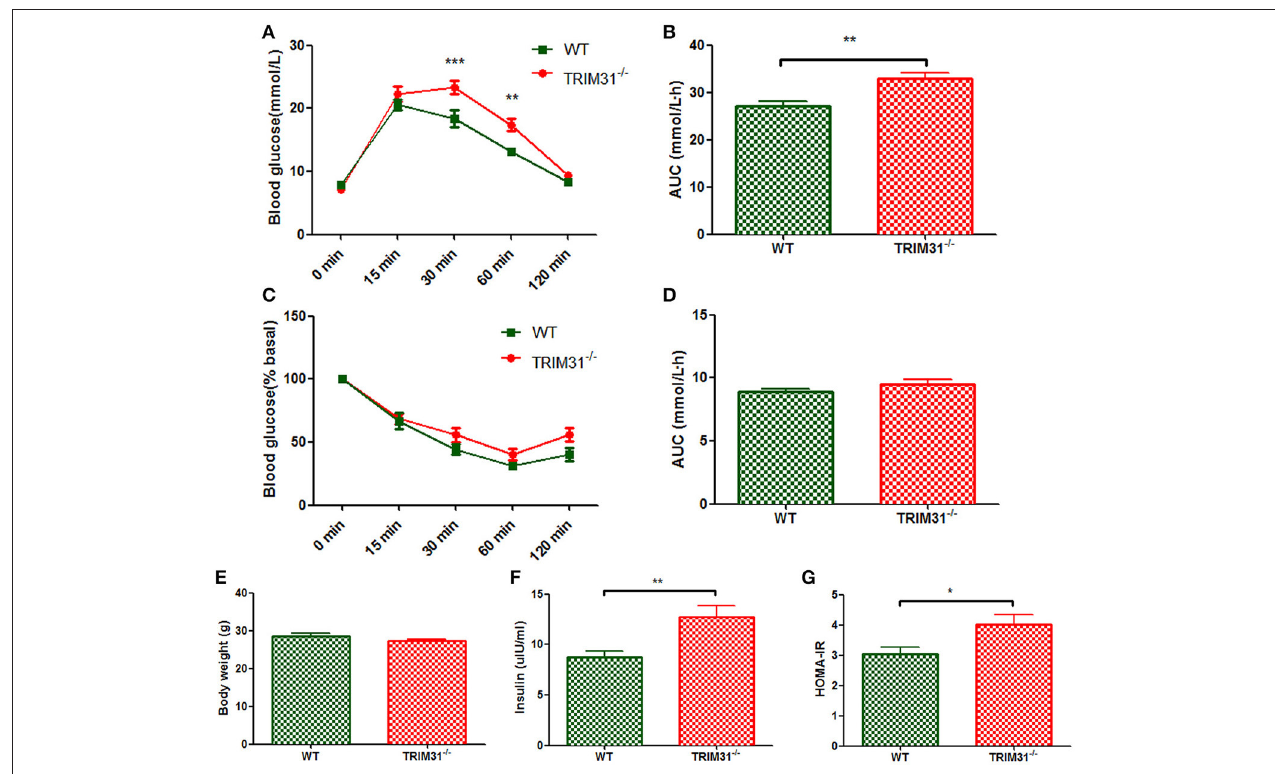
FIGURE 2 | Metabolic parameters of TRIM31 − / − and WT mice at age 20 weeks. (A) Glucose tolerance test, (B) AUC for glucose tolerance, (C) Insulin tolerance test, (D) AUC for insulin tolerance test, (E) Body weight at age 20 weeks, (F) Serum insulin level, (G) HOMA-IR level. n = 10, in each group. * P < 0.05, ** P < 0.01, *** P < 0.001 TRIM31 − / − vs. WT mice. AUC, area under the receiver operating characteristic curve; HOMA-IR, Homeostasis model assessment of insulin resistance; WT, wild-type; TRIM31, tripartite motif-containing protein